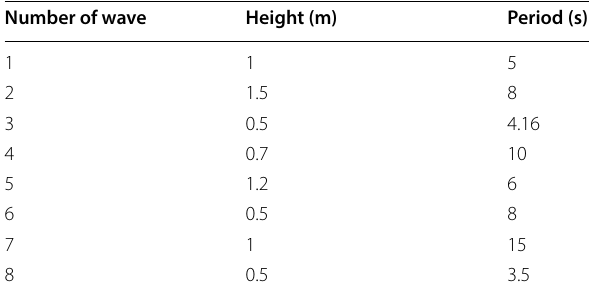
Table 3 Random wave conditions for final evluation of proposed control strategies